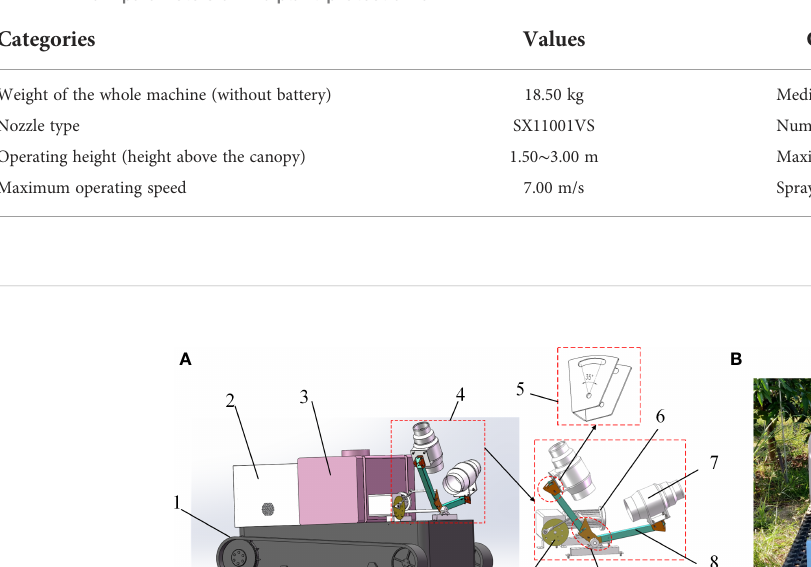
TABLE 1 Main parameters of T16 plant-protection UAV.